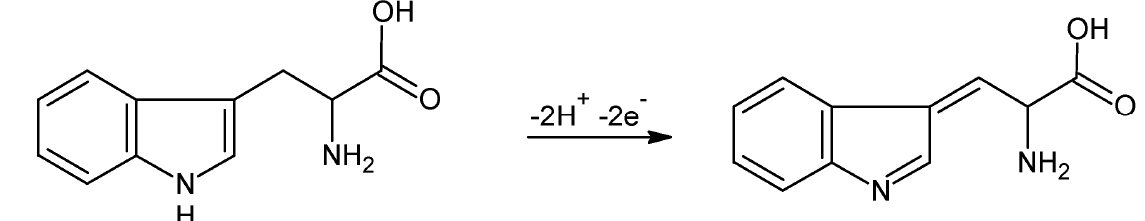
Figure 12. Process of the electrochemical oxidation of L-TRP by PPy/FeCN/SPCE sensor [28].